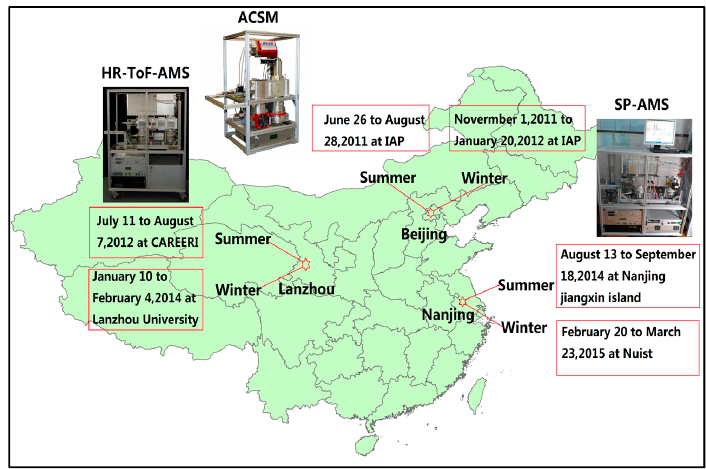
Figure 1. Sampling periods, locations, and aerosol mass spectrometers (AMS) versions of the datasets used in this work.